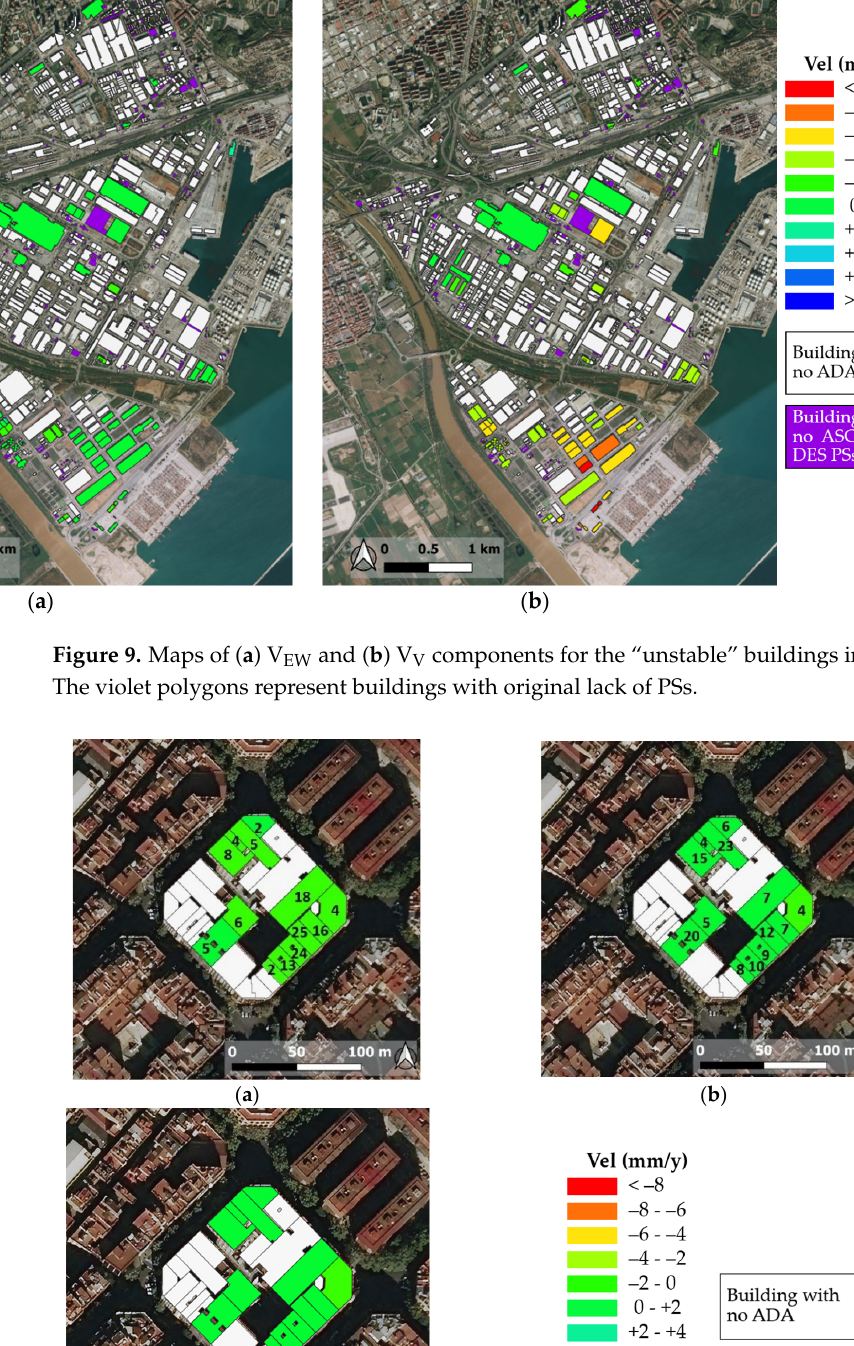
Figure 8. Maps of ( a ) V EW and ( b ) V V components for the “unstable” buildings in Eixample area. The violet polygons represent buildings with original lack of PSs.